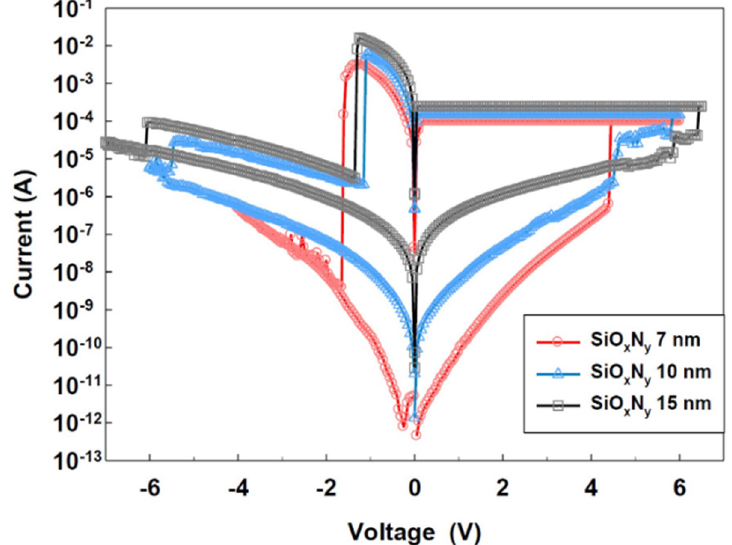
Figure 7. I-V characteristics of Au / Ni / SiO x N y / p + -Si memory devices with various SiOxNy thicknesses.